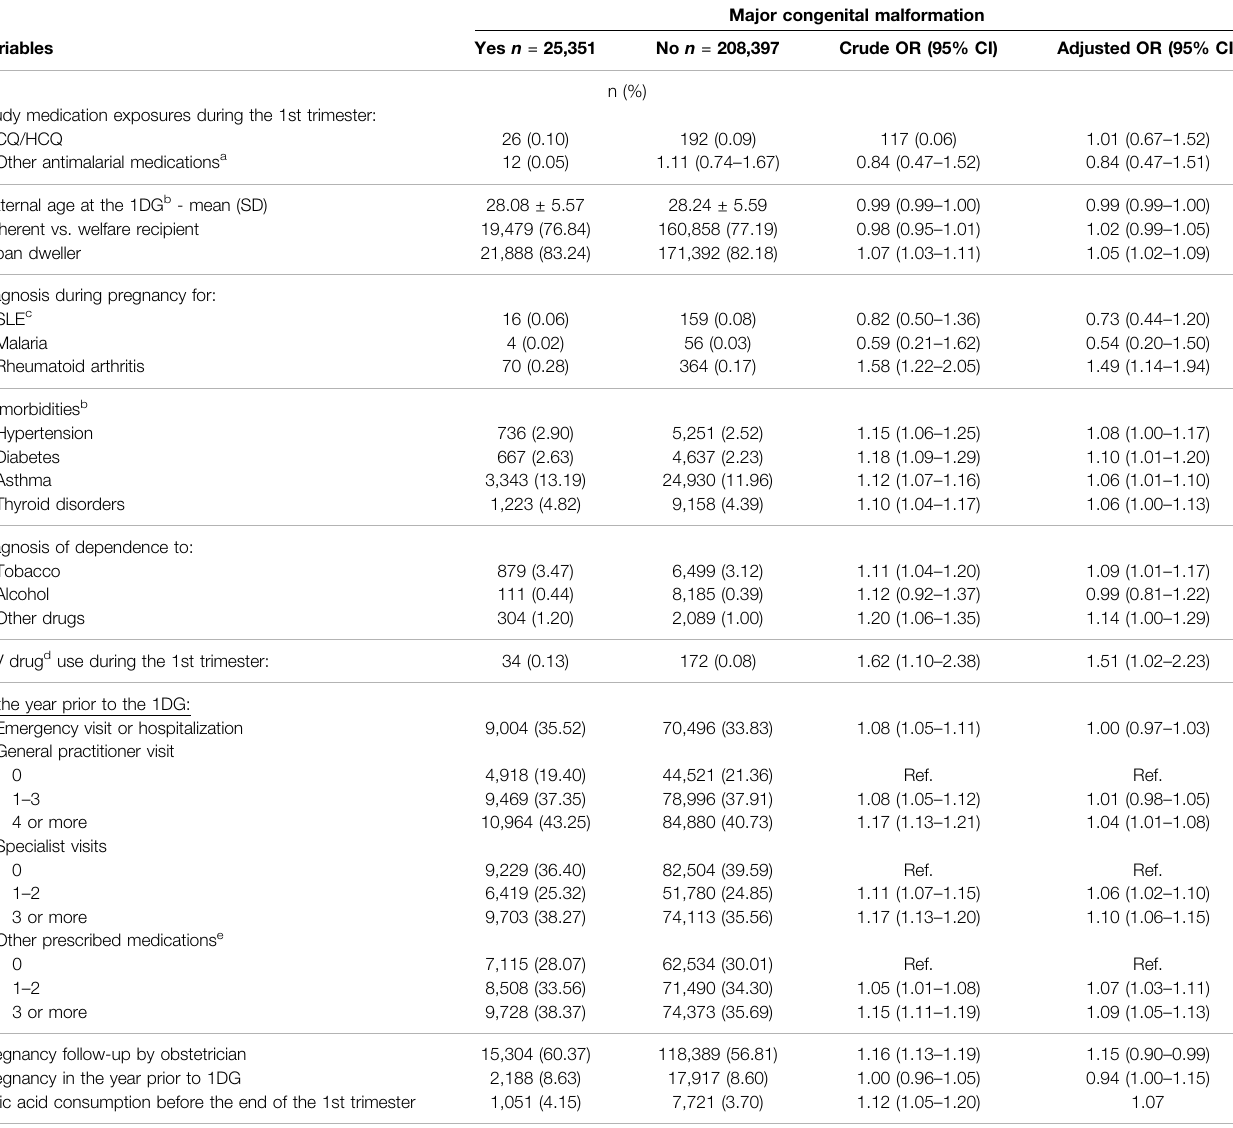
TABLE 4 | Association between CQ/HCQ exposure during the fi rst trimester and the risk of overall major congenital